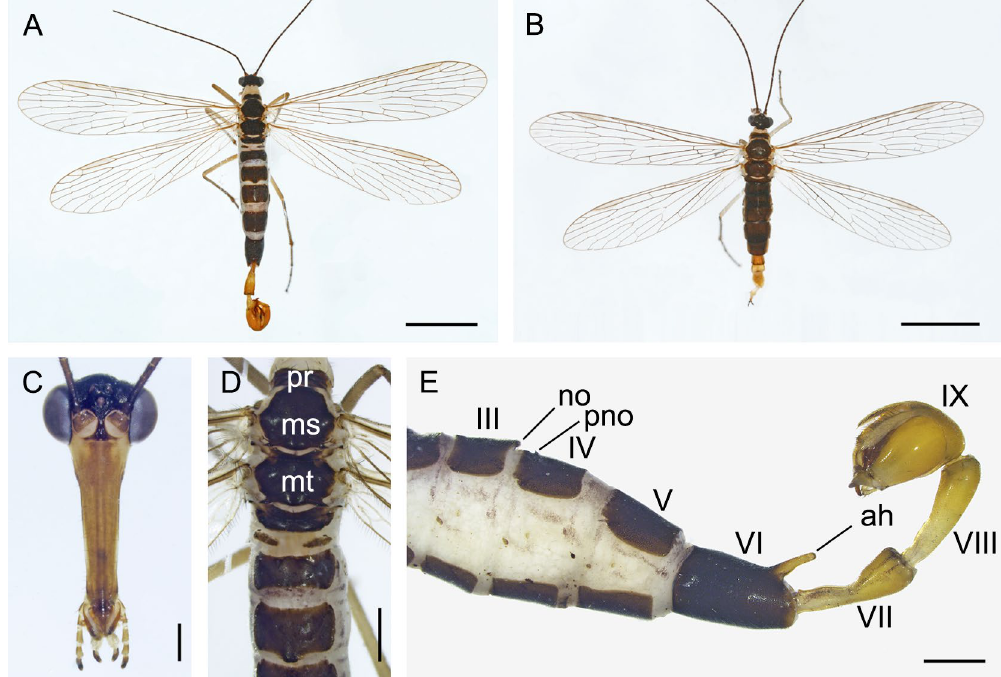
Fig. 5. Adults of Cerapanorpa baimaensis sp. nov. A . Male habitus in dorsal view. B . Female habitus in dorsal view. C . Male head in frontal view. D . Dorsum of male. E . Male abdomen in lateral view. Abbreviations: ah = anal horn; ms = mesonotum; mt = metanotum; no = notal organ; pno = postnotal organ; pr = pronotum. Scale bars: A–B = 5 mm; C = 0.5 mm; D–E = 1